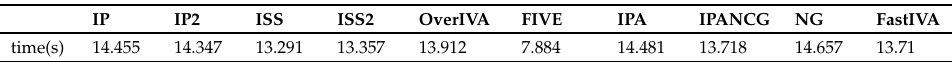
Table 2. Algorithms’ running